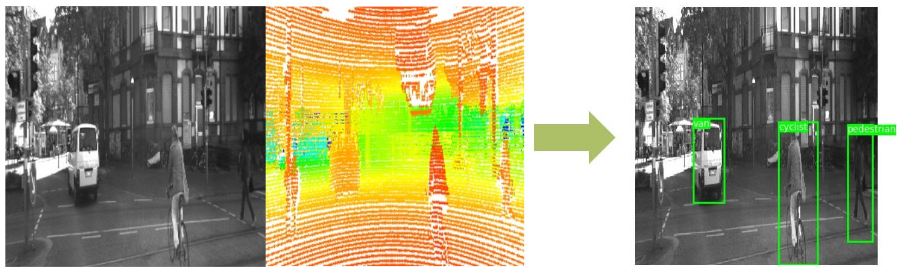
Figure 5. Input data on the left side of the figure and output on the right